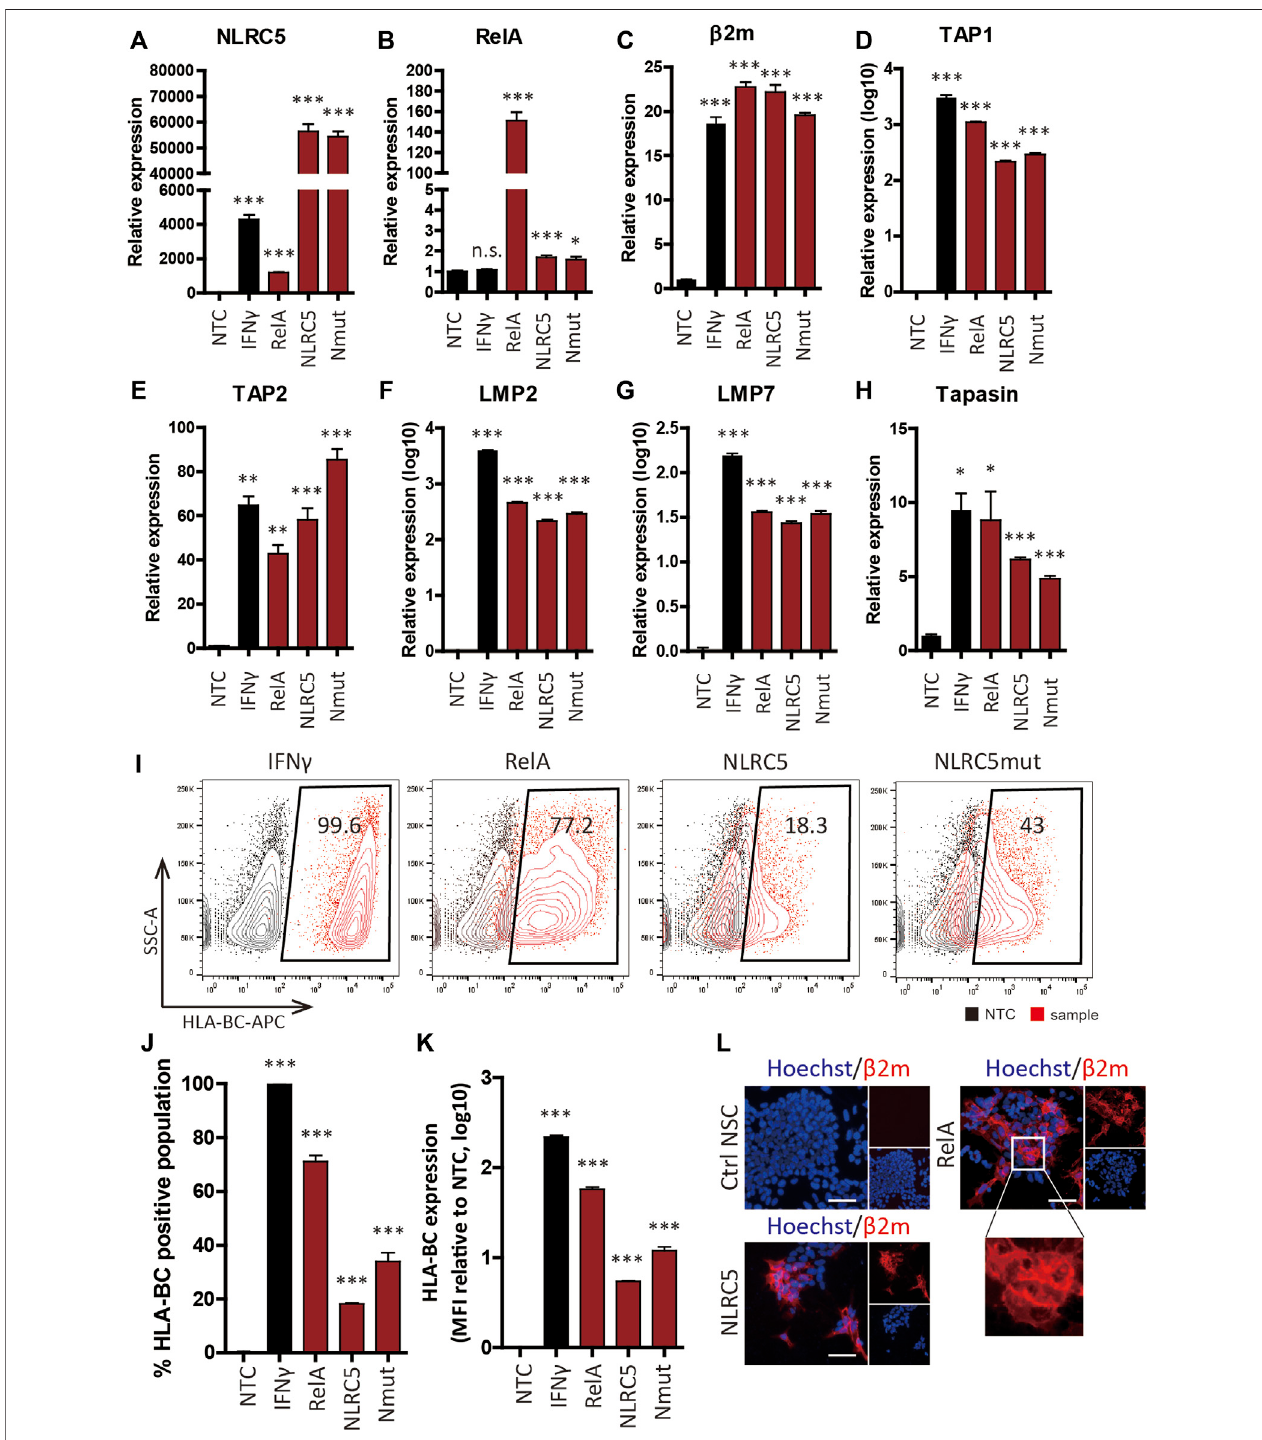
FIGURE 5 | Upregulation of APM gene expression and HLA class I molecule surface presentation by transcription factors. (A – H) Relative mRNA levels in non- transfected control (NTC), IFN- γ -treated (IFN- γ ), RelA-transfected (RelA), NLRC5-transfected (NLRC5), and constitutive mutant form of NLRC5-transfected (Nmut) NSCs ( n = 4). (I) Representative fl ow cytometry plot of surface HLA-BC presentation. (J,K) Percentage HLA-BC-positive populations (J) and MFI values compared to NTCs (K) , ( n = 4). (L) Immunocytochemistry of β 2m surface presentation in response to transcription factors. Magni fi ed image shows β 2m on the cell surface; all images are fl uorescence micrographs. Scale bar, 50 μ m. Data are means ± SEMs.